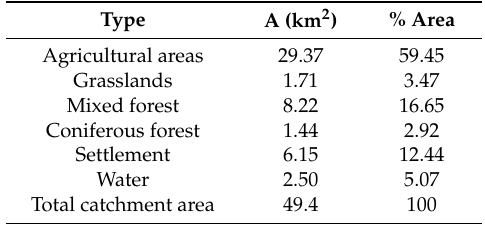
Table 2. Land use information of the Łęgoń watershed.